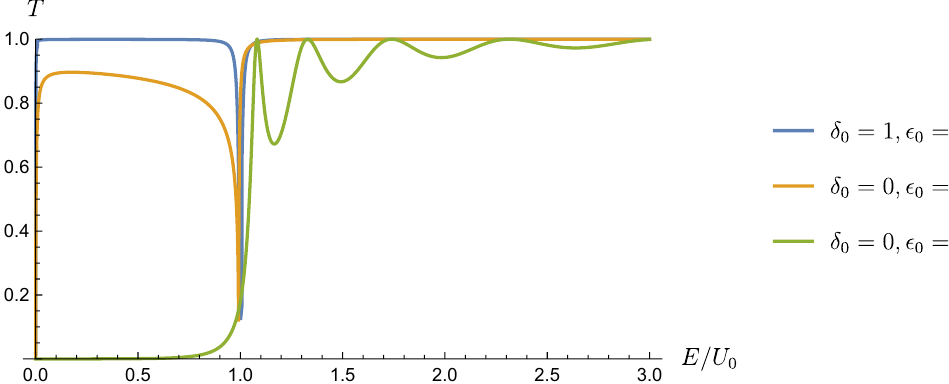
Figure 2. Transmission coefficient for a barrier of width L = 1 (cid:96) Pl and height U 0 = 120 ¯ h 2 /mL 2 . In green is the standard case, while the blue and orange lines correspond to two different parametriza- tions of the model in Equation (20). It is worth observing that, while the standard case predicts a vanishing transmission coefficient at an energy below U 0 , this is not the case in models with a minimal